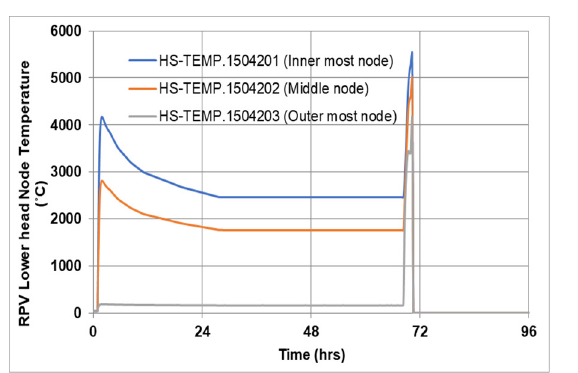
Fig. 8. MELCOR temperature profiles of